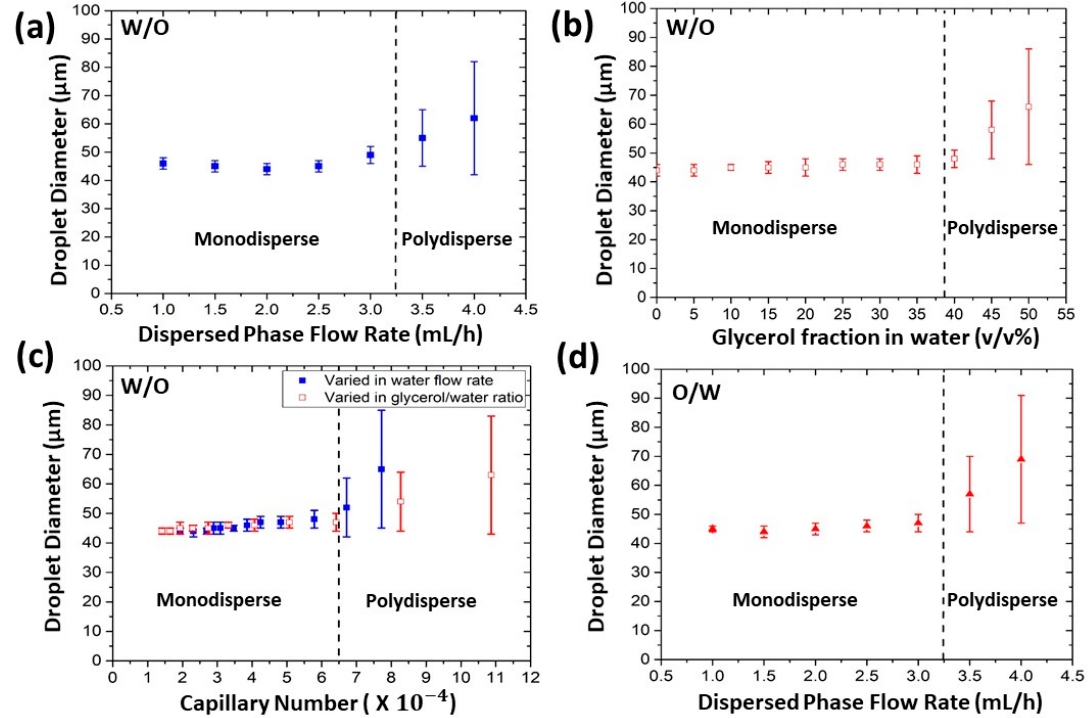
Figure 3. The experimental results of the W / O and oil-in-water (O / W) droplets in various conditions. ( a ) W / O droplets diameter versus the flow rates of the dispersed phase. The droplet size is insensitive for varying dispersed phase flow rates when it is below the critical value (indicated by the dashed line in the figure). ( b ) W / O droplet diameter versus the fraction of the glycerol in water mixture ratio. The flow rate of the dispersed phases is 1.5 mL / h. ( c ) W / O droplet diameter versus the capillary number. The capillary number was calculated based on the dispersed phase flow rate. The data from varied water flow rate (blue) and varied glycerol in water ratio (red) agreed well, indicating a critical Ca of 6.5 × 10 − 4 for uniform droplet generation. ( d ) O / W droplet diameter versus the flow rate of the dispersed oil phase.